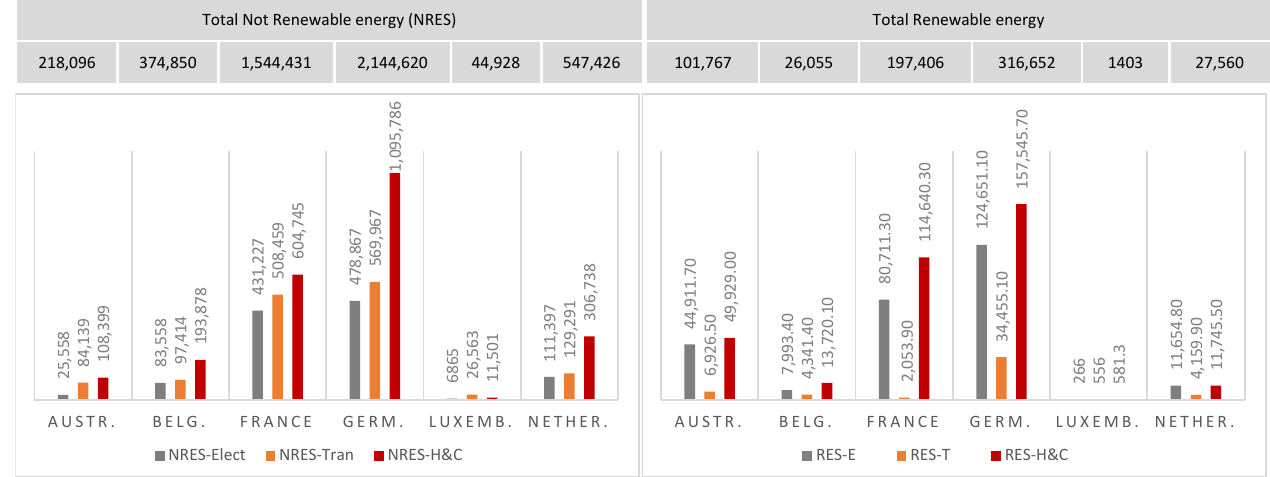
Figure 3. Energy consumption (GWh) in 2011.